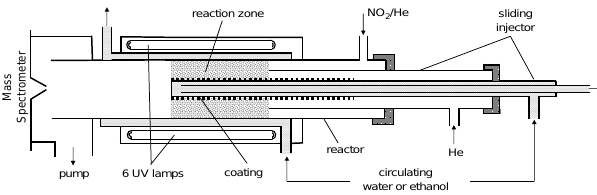
Fig. 1. Diagram of the flow photoreactor